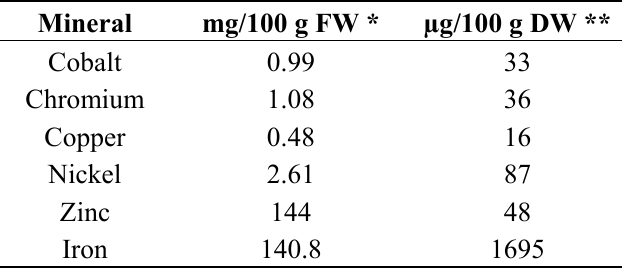
Table 3. Mineral contents of fruit